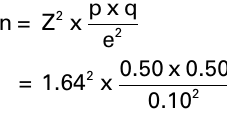
Figure 1. Sex-wise distribution of the patients with increased GSV diameter (n= 59).